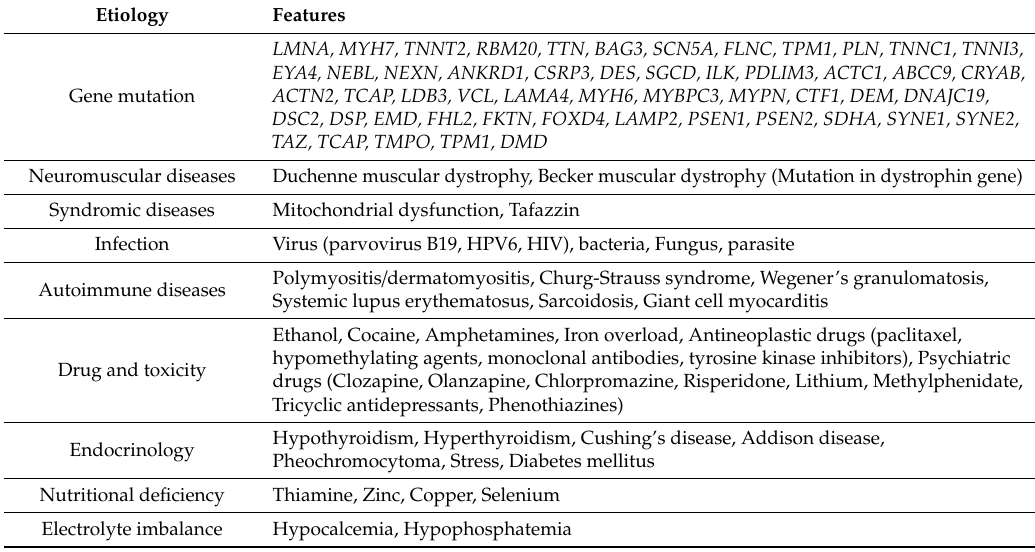
Table 1. Common etiologies of dilated